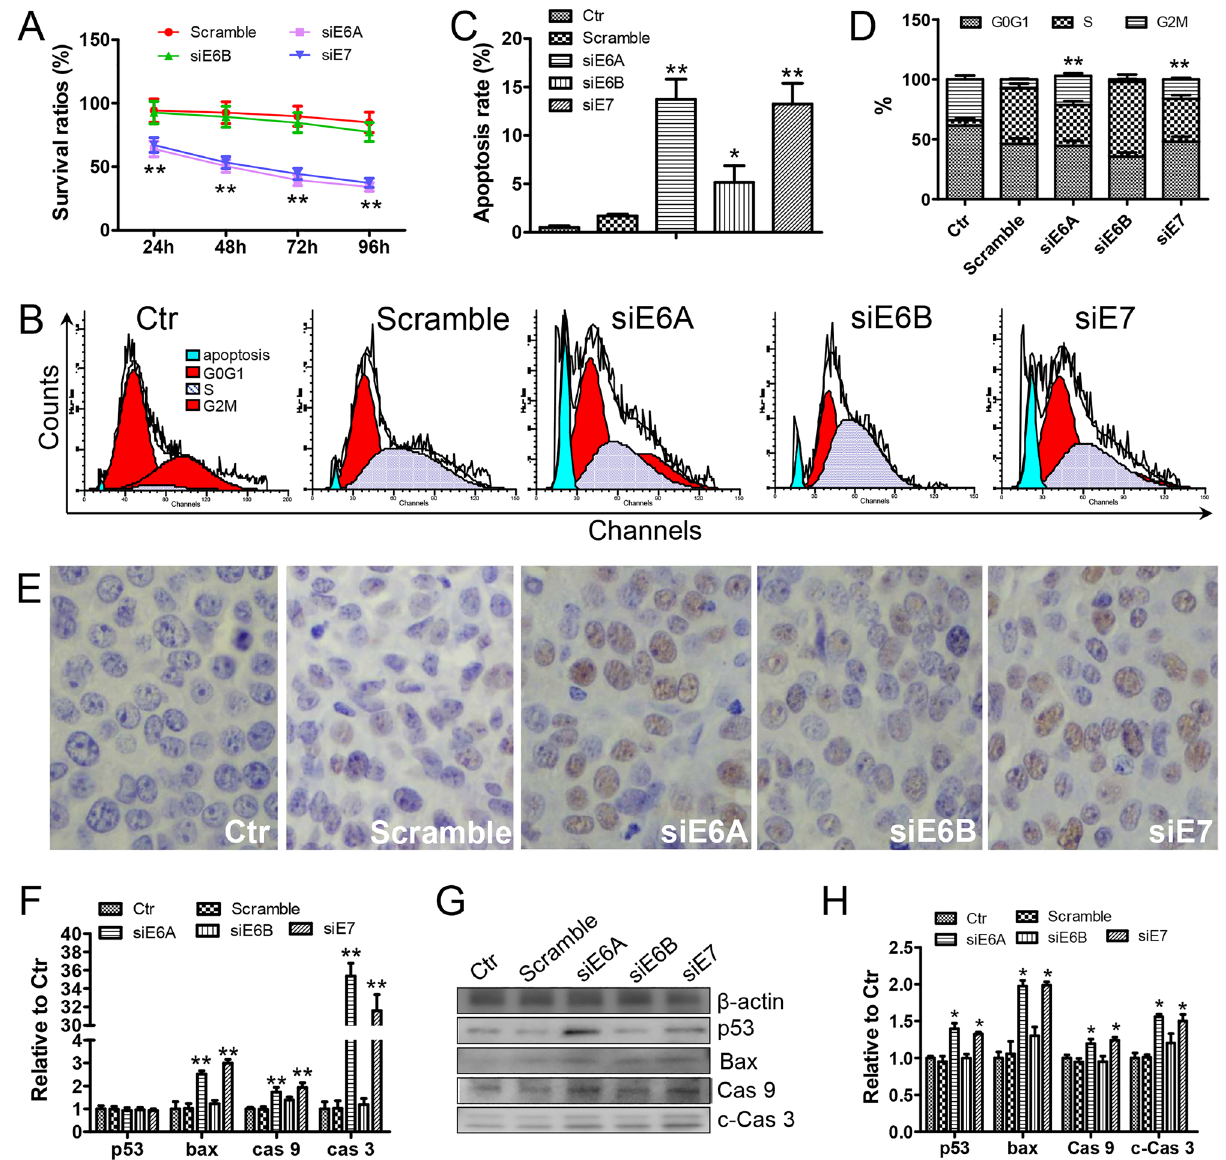
Figure 4. The pCG-siE6A and pCG-siE7 can promote the apoptosis of Siha cells. ( A ) Survival ratios for Siha cells transfected with pGC-siRNA plasmids (n = 3). **P < 0.01, vs the control group. ( B , C ) FCAS analysis for apoptosis rates of Siha cells transfected with pGC-siRNA plasmids. *P < 0.05, **P < 0.01, vs the two control groups. ( D ) FCAS analysis for cell cycle of Siha transfected with pGC-siRNA plasmids. **P < 0.01, vs the Scramble group. ( E ) TUNEL analysis for Siha cells transfected with pGC-siRNA plasmids (× 400). ( F ) Semi- quantitative RT-PCR analysis of mRNA in Siha cells transfected with pGC-siRNA plasmids, **P < 0.01, vs the two control groups. ( G , H ) Western blotting analysis of related protein in Siha cells transfected with pGC-siRNA plasmids, *P < 0.05, vs the two control